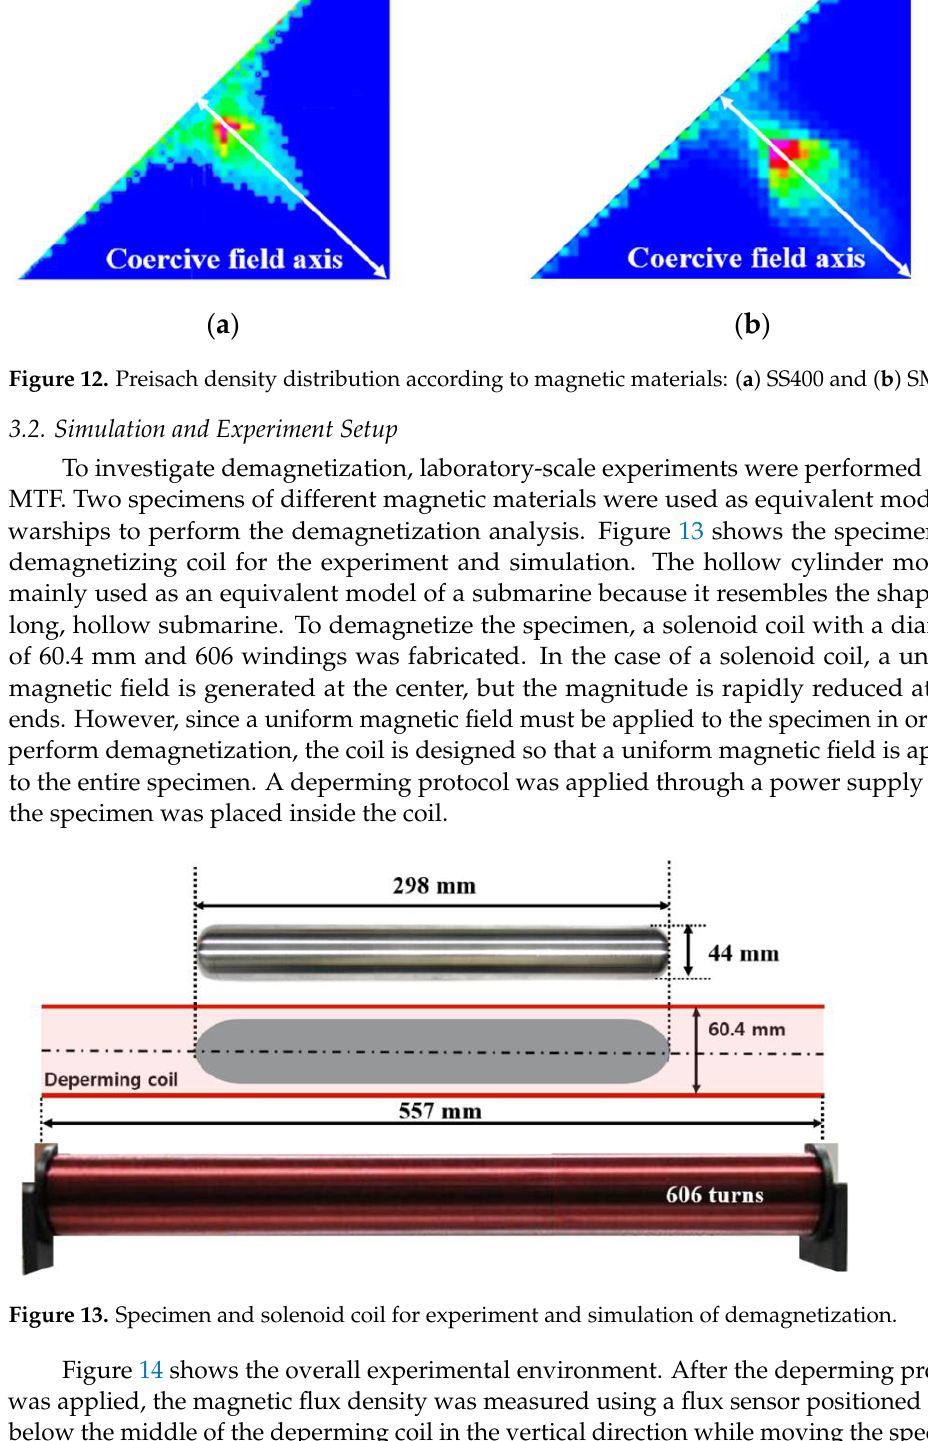
Figure 13. Specimen and solenoid coil for experiment and simulation of demagnetization.